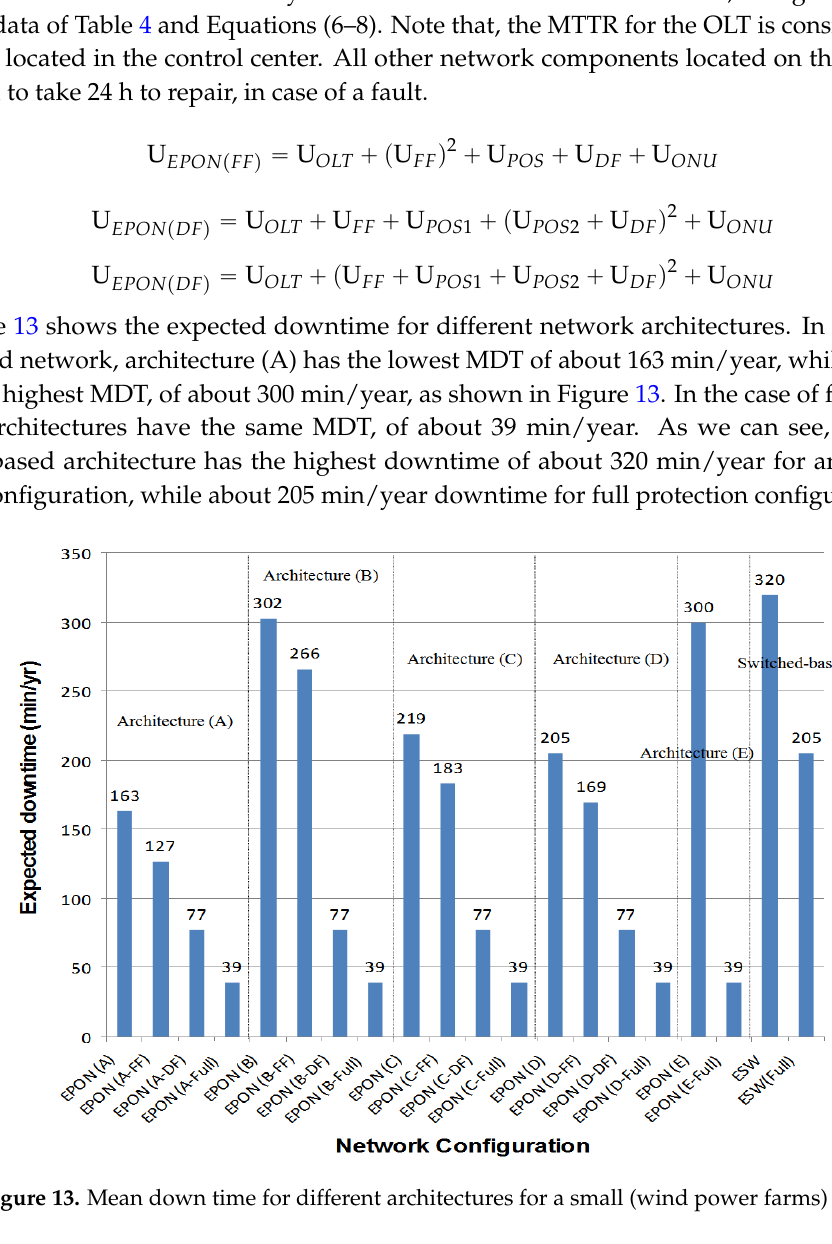
Figure 12. Reliability block diagram for Full protection architecture.